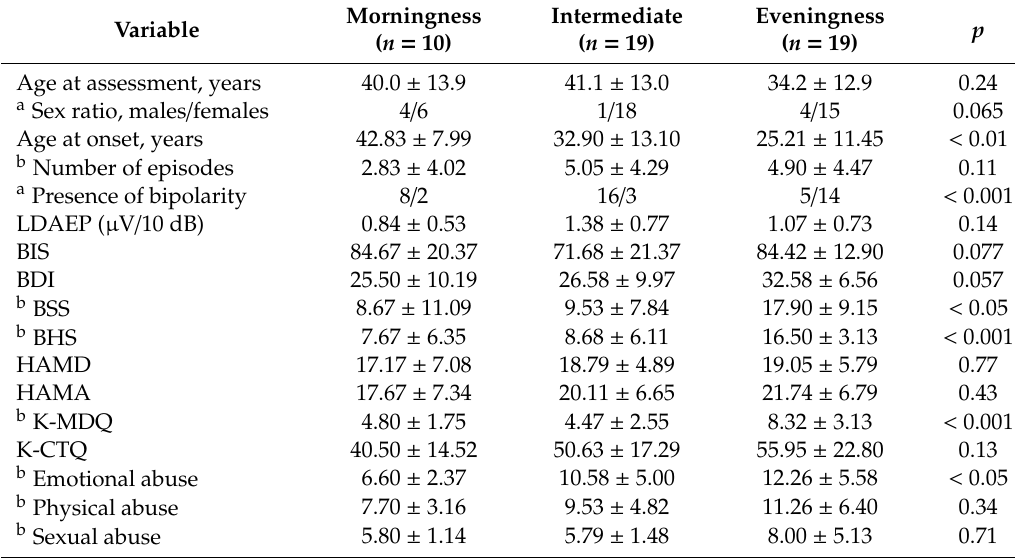
Table 1. Comparison of demographic and clinical variables among the morningness, intermediate, and eveningness groups classified according to circadian preference based on the Korean version of the Composite Scale of Morningness